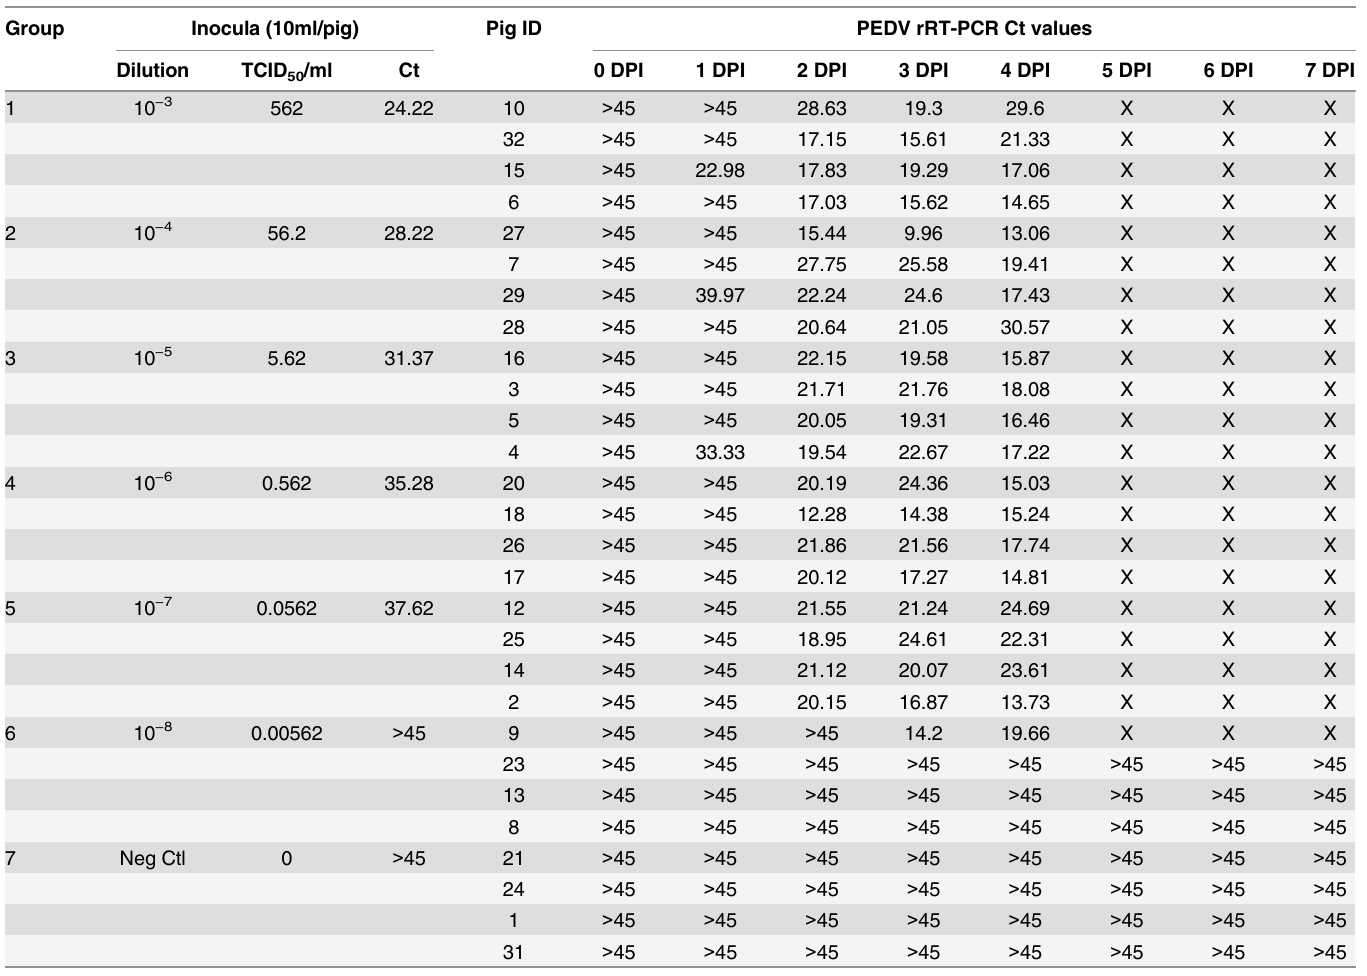
Table 3. PEDV shedding in rectal swabs of the neonatal piglets. * Group Inocula